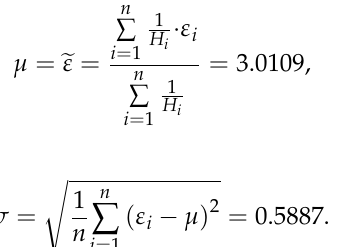
Figure 15. The histogram of the recovered permittivity.